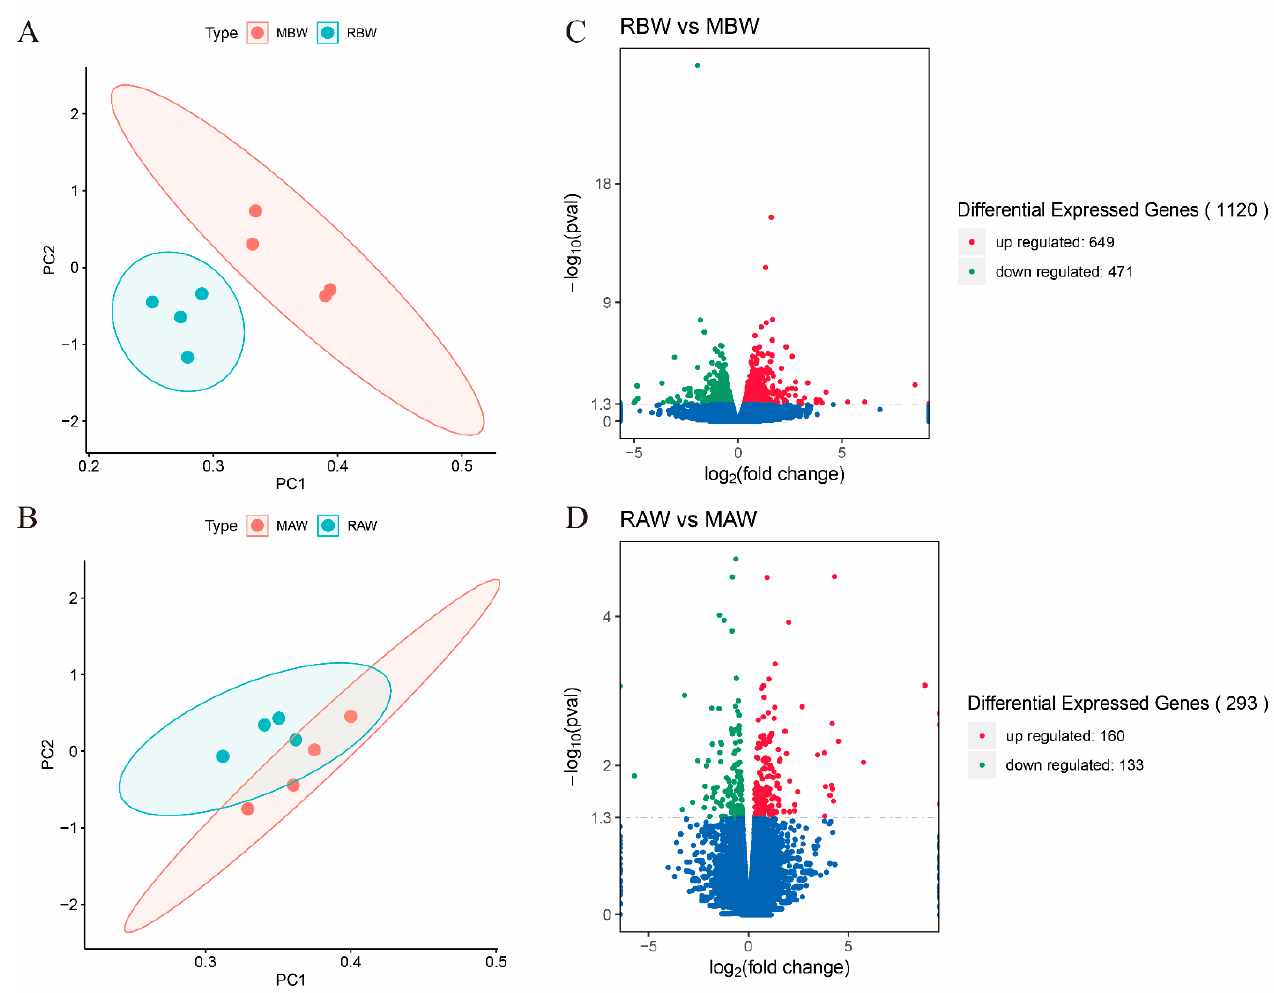
Figure 1. Gene expression between milk and milk replacer groups. ( A ) The principal component analysis (PCA) of all genes in liver between MBW and RBW. ( B ) The principal component analysis (PCA) of all genes in liver between MAW and RAW. ( C ) The expression of differentially expressed genes between two groups during pre-weaning period. ( D ) The expression of differentially expressed genes between two groups during post-weaning period. The red dots indicate upregulated differentially expressed genes and the green dots indicate downregulated differentially expressed genes. The blue dots reveal that there is no difference in the expression of genes between the two groups. MBW (liver samples from the milk group before weaning); RBW (liver samples from the milk replacer group before weaning); MAW (liver samples from the milk group after weaning); RAW (liver samples from the milk replacer after weaning).